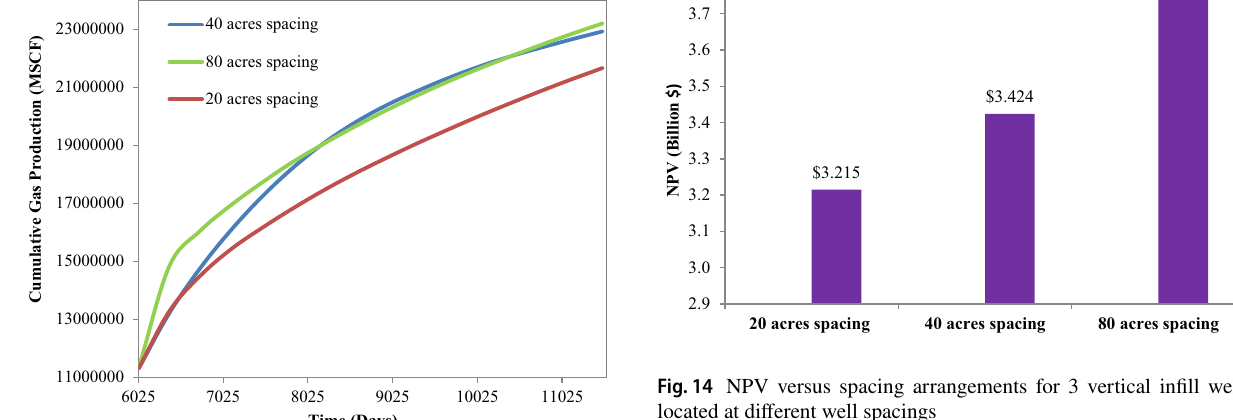
Fig. 14 NPV versus spacing arrangements for 3 vertical infill wells located at different well